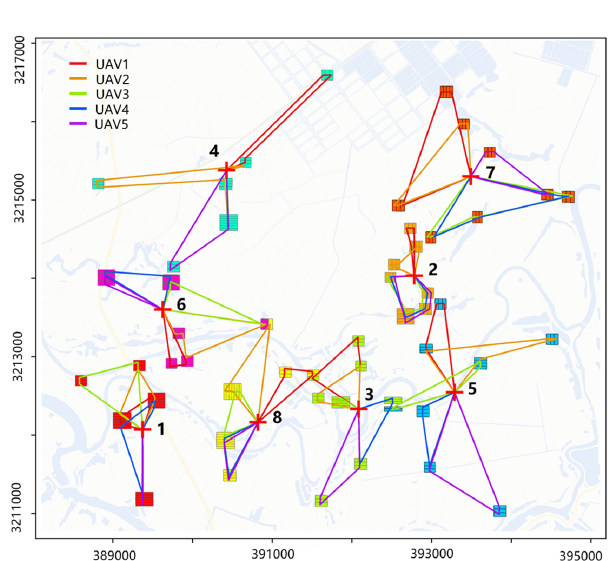
Figure 7 shows the flight trajectories of the UAV swarm. The tasks linked by the same color line represent task sequences executed by the same UAV; the five different colored lines represent the five UAVs. The red crosses represent the UAV takeoff and landing points. The number indicates the different task subsets; a task with the same color indi- cates that it belongs to the same task subset.